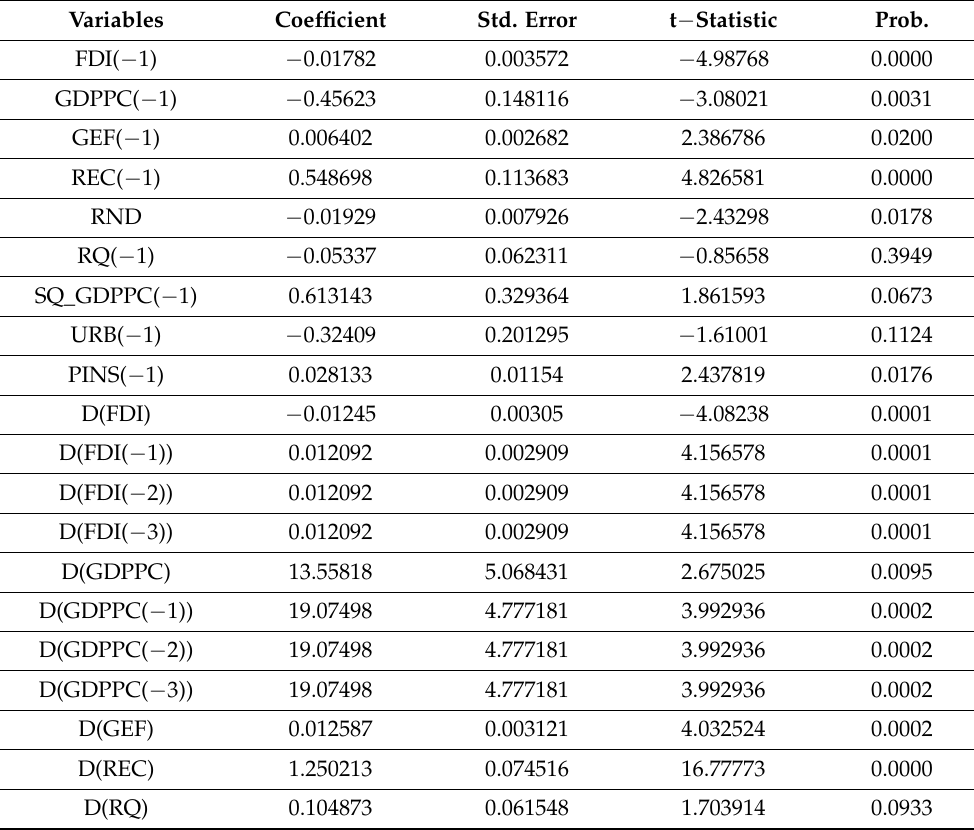
Table 6. ARDL Short- and Long-Term